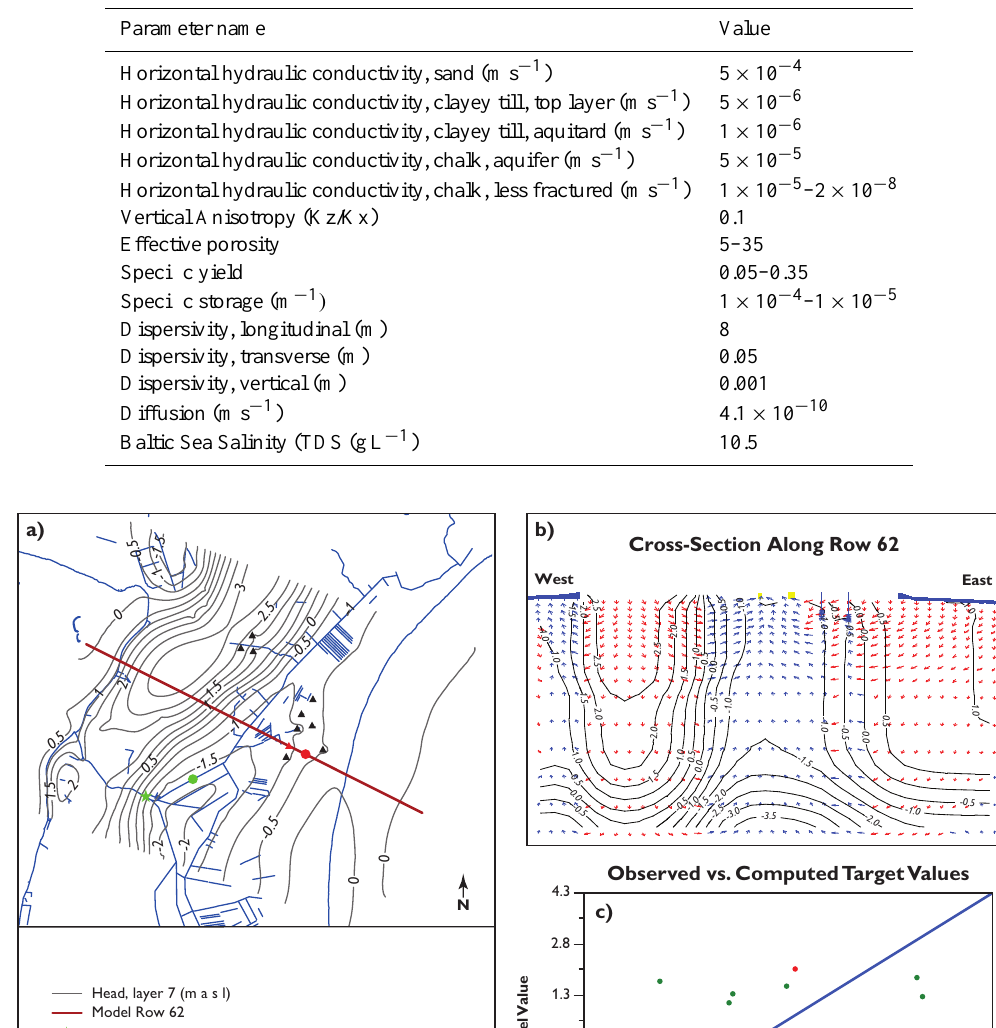
Table 6. Model parameters.